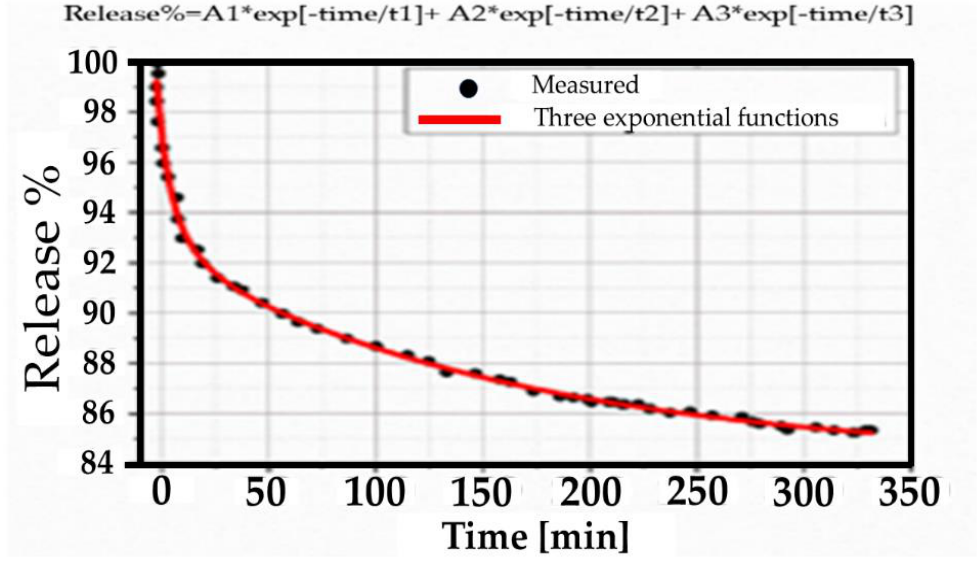
Figure 16. Release of 8-HQ from CeMo nanocontainers with time (Adapted with permission from Ref. [150]).